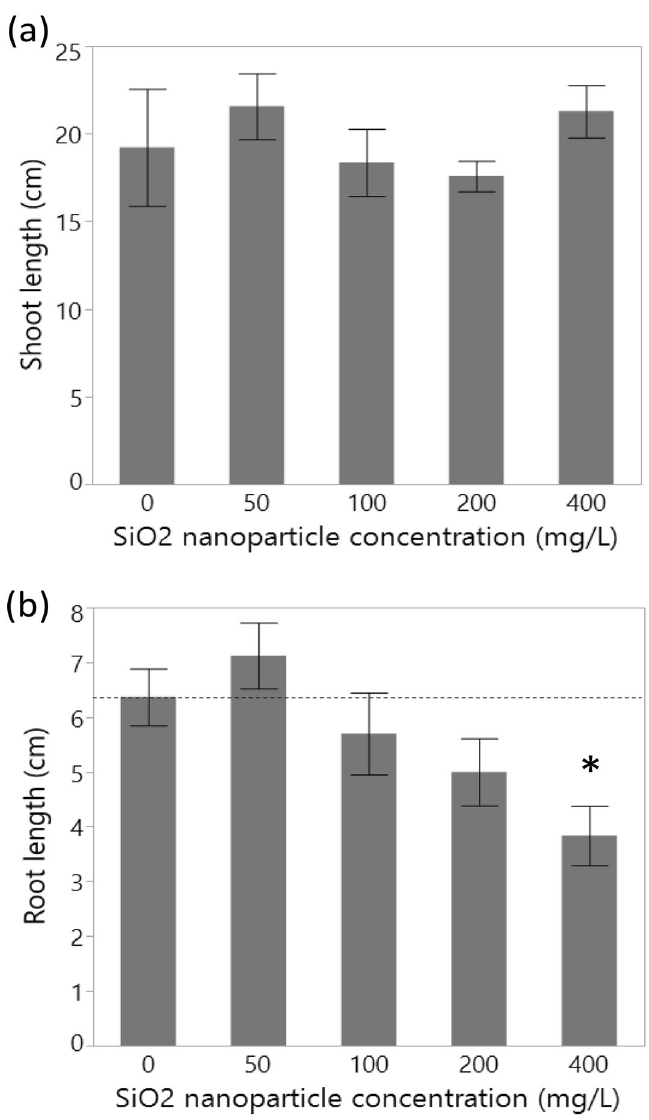
Figure 6. Concentration-dependent effects of silica (SiO 2 ) nanoparticles on ( a ) shoot and ( b ) root lengths of faba bean ( Vicia faba ) seedlings. An asterisk indicates a significant difference from the